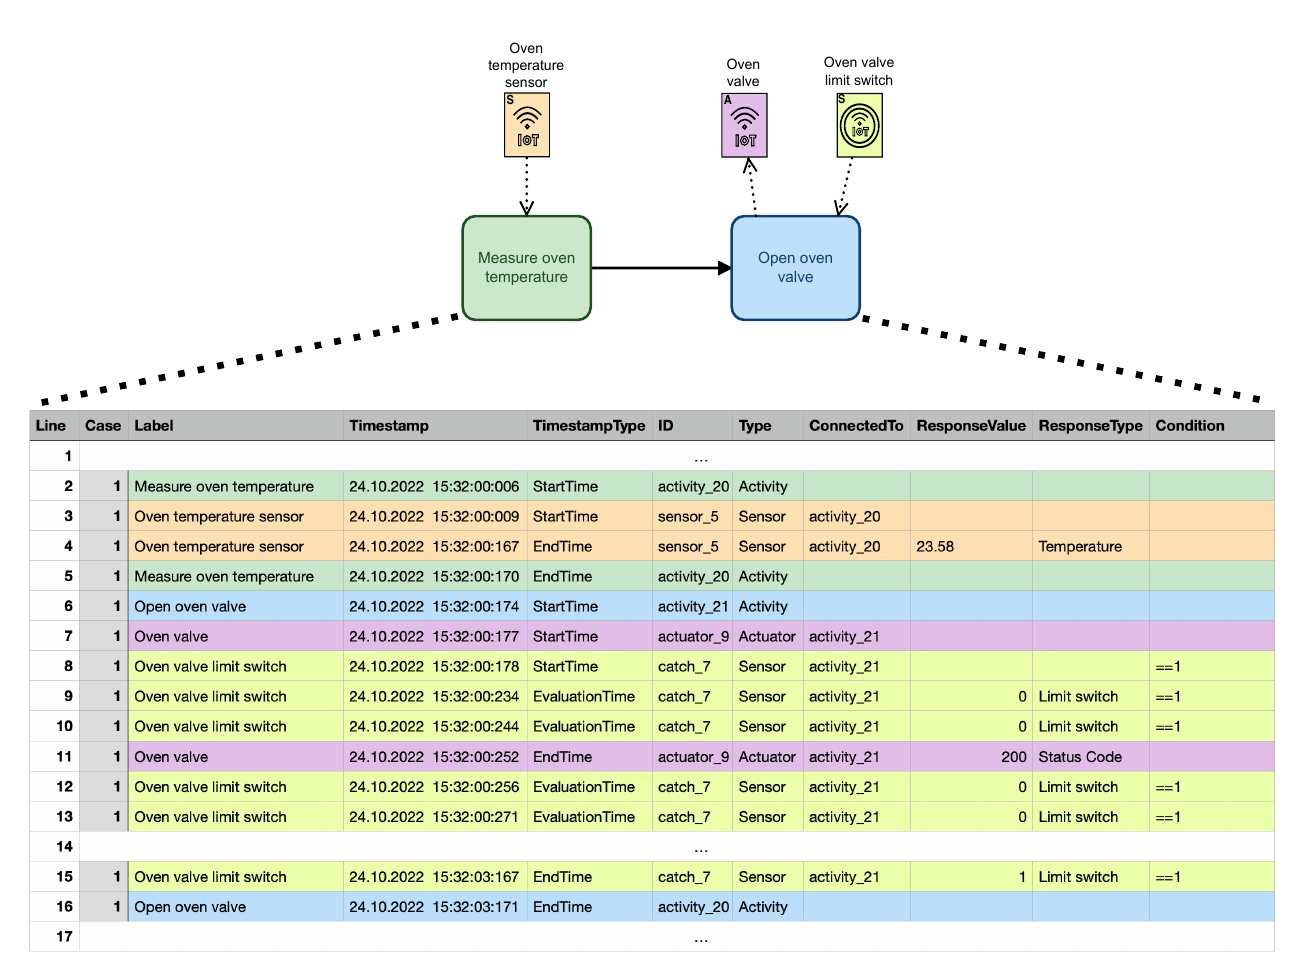
Figure 13. Excerpt of an output event log showing a segment of an IoT-driven Process in CSV